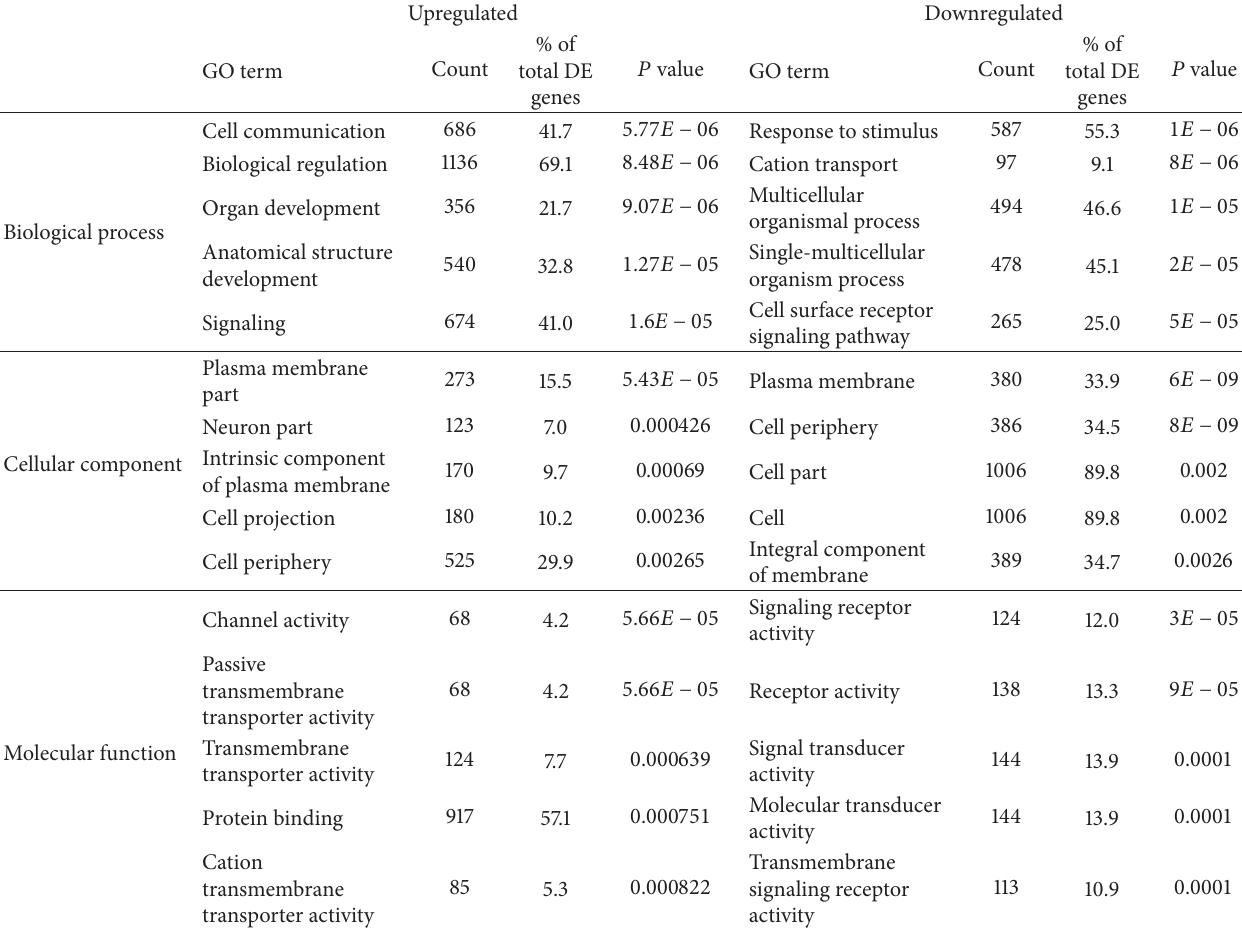
Table 4: Results of bioinformatics GO (gene ontology) enrichment analyses to determine the roles of differentially expressed mRNAs in GO